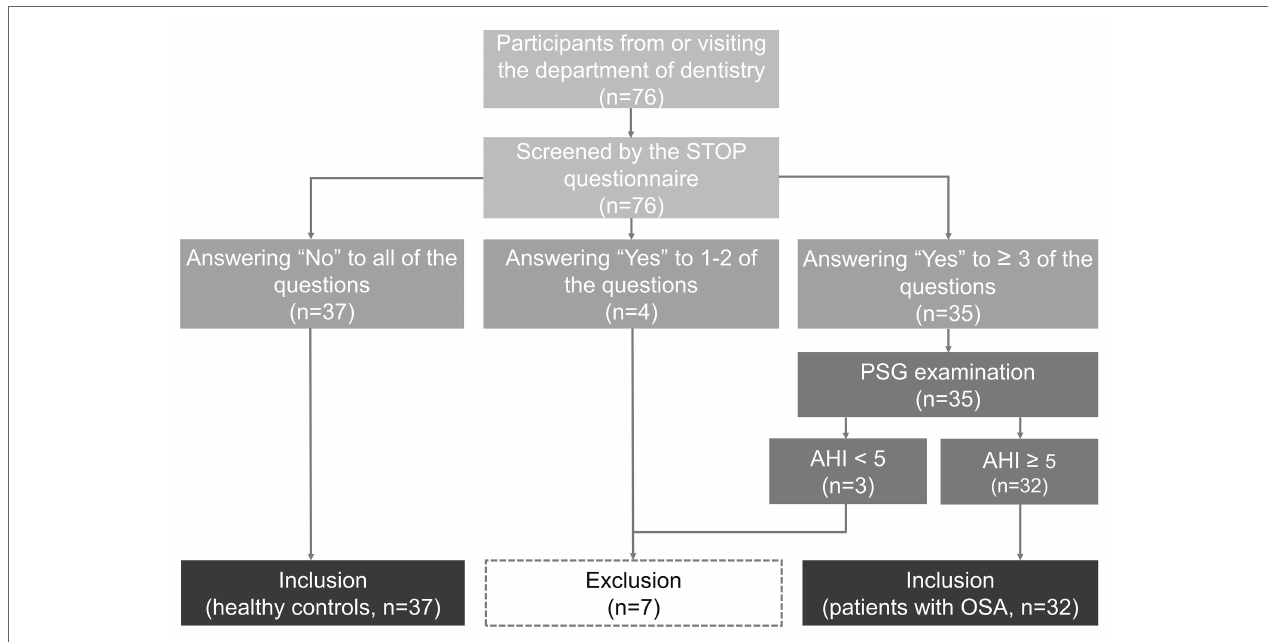
FIGURE 1 | Flow diagram of participant recruitment. OSA, obstructive sleep apnea; PSG, polysomnography; and AHI, Apnea Hypopnea